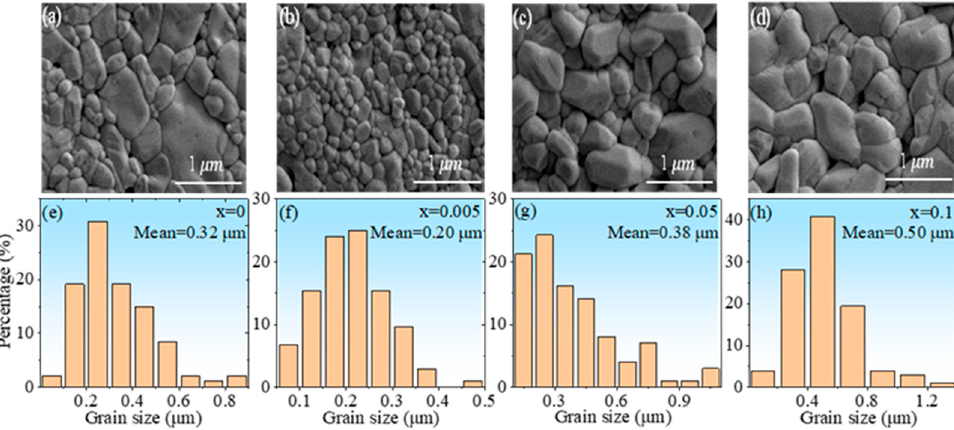
Figure 4. ( a – d ) SEM images of ceramic samples and ( e – h ) the corresponding particle size distribu- tions.